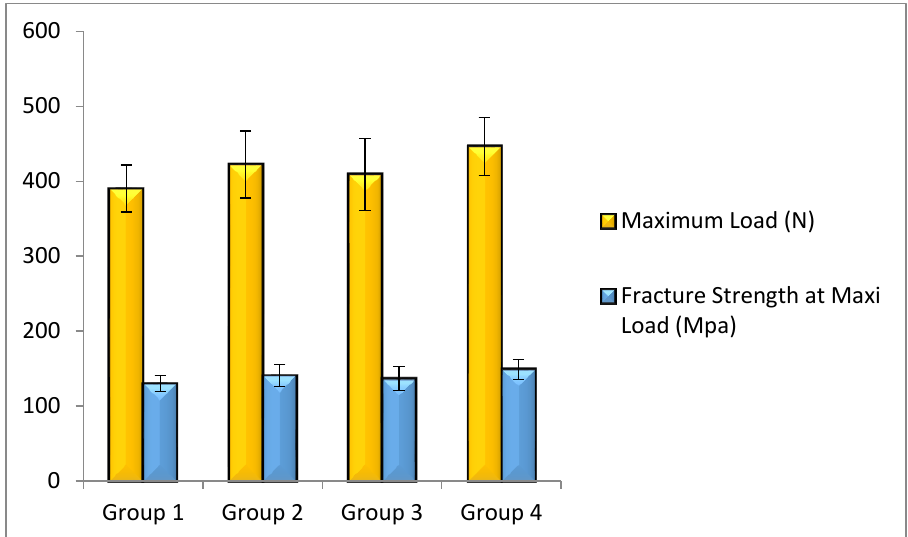
Figure 3. Means of fracture strength and maximum load of each group.